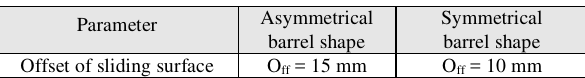
Fig. 10. Piston ring pack geometry under consideration: a) asymmetrical barrel shape of all rings, b) symmetrical barrel shape of rings 2, 3 and 4 Fig. 8. Comparison of the oil film thickness h oil [ m m] left by the piston ring pack along cylinder wall in case of the offset O ff = 5 mm and O ff = 15 mm of the 1 st (top) ring Table 5. Chosen geometric parameter of piston rings 2, 3 and 4